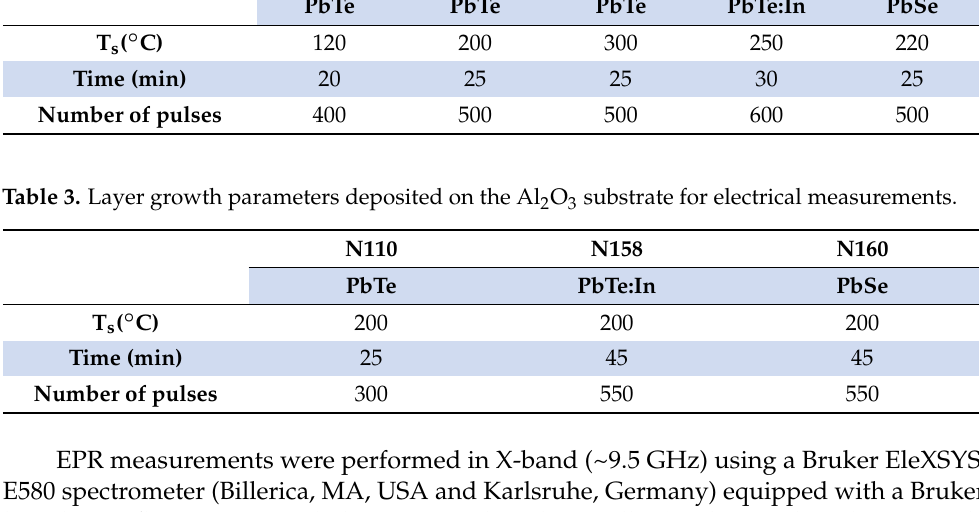
Table 2. Layer growth parameters deposited on a quartz substrate for EPR measurements. N111